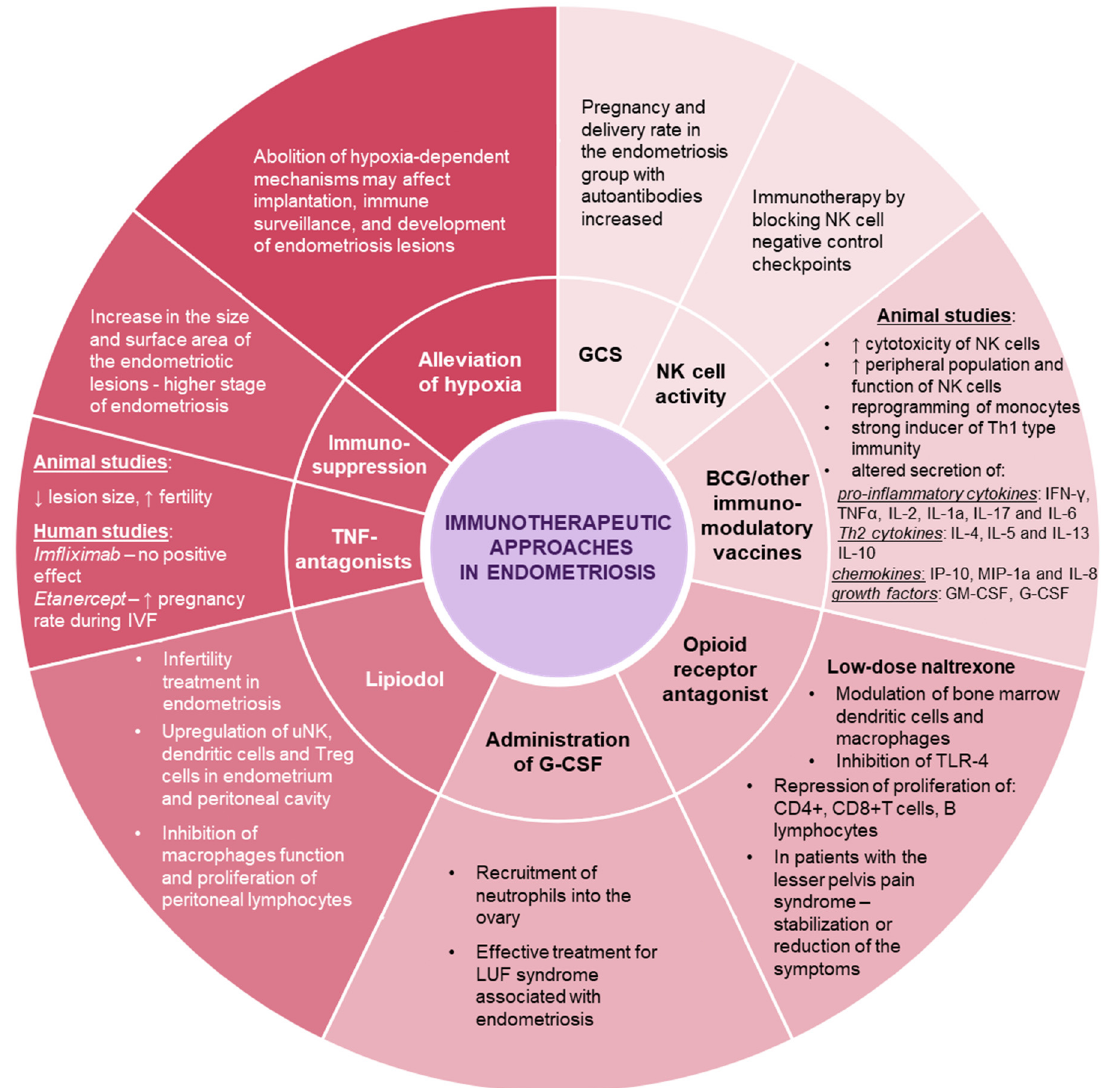
Figure 2. Schematic representation of the therapeutic approaches that can modulate the immune system in endometriosis ( ↑ − increased , ↓ − decreased).